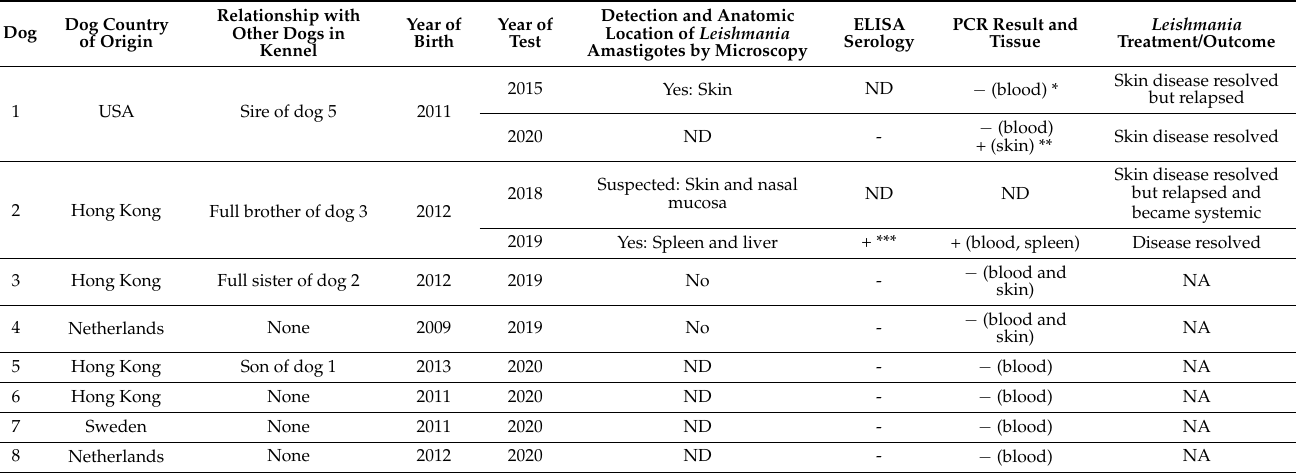
Table 1. Signalment, origin, main test results, and Leishmania treatment outcome of eight dogs living in the same kennel investigated for